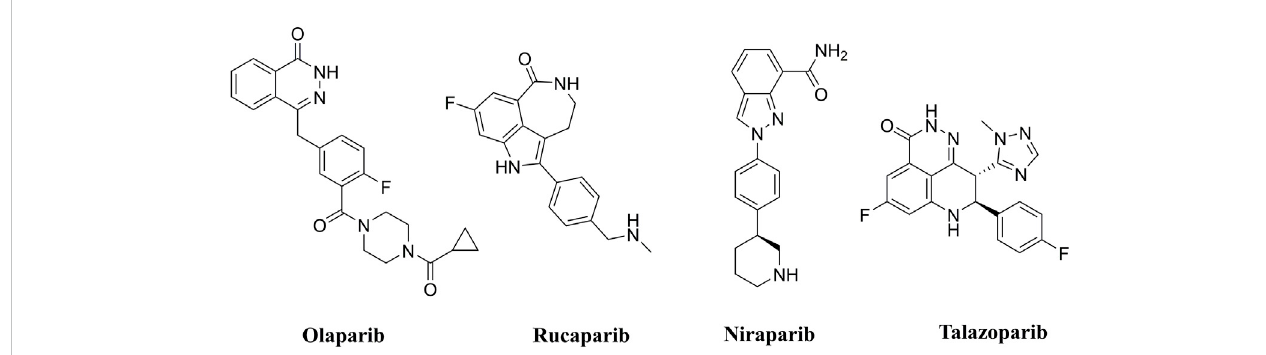
FDA approved PARP inhibitors utilized for the treatment of cancer.